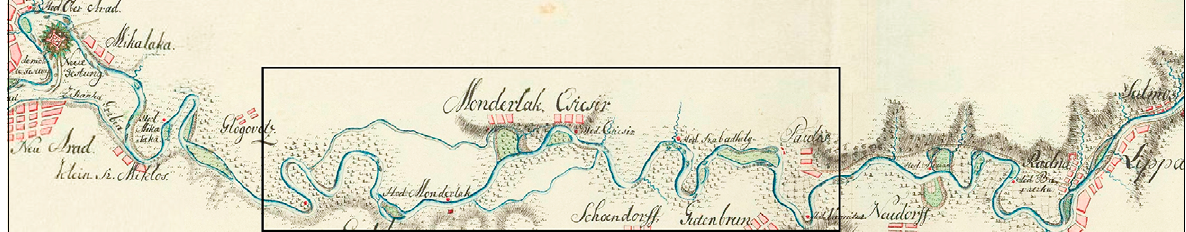
Figure 6. The map of Mureș River in 1805 (